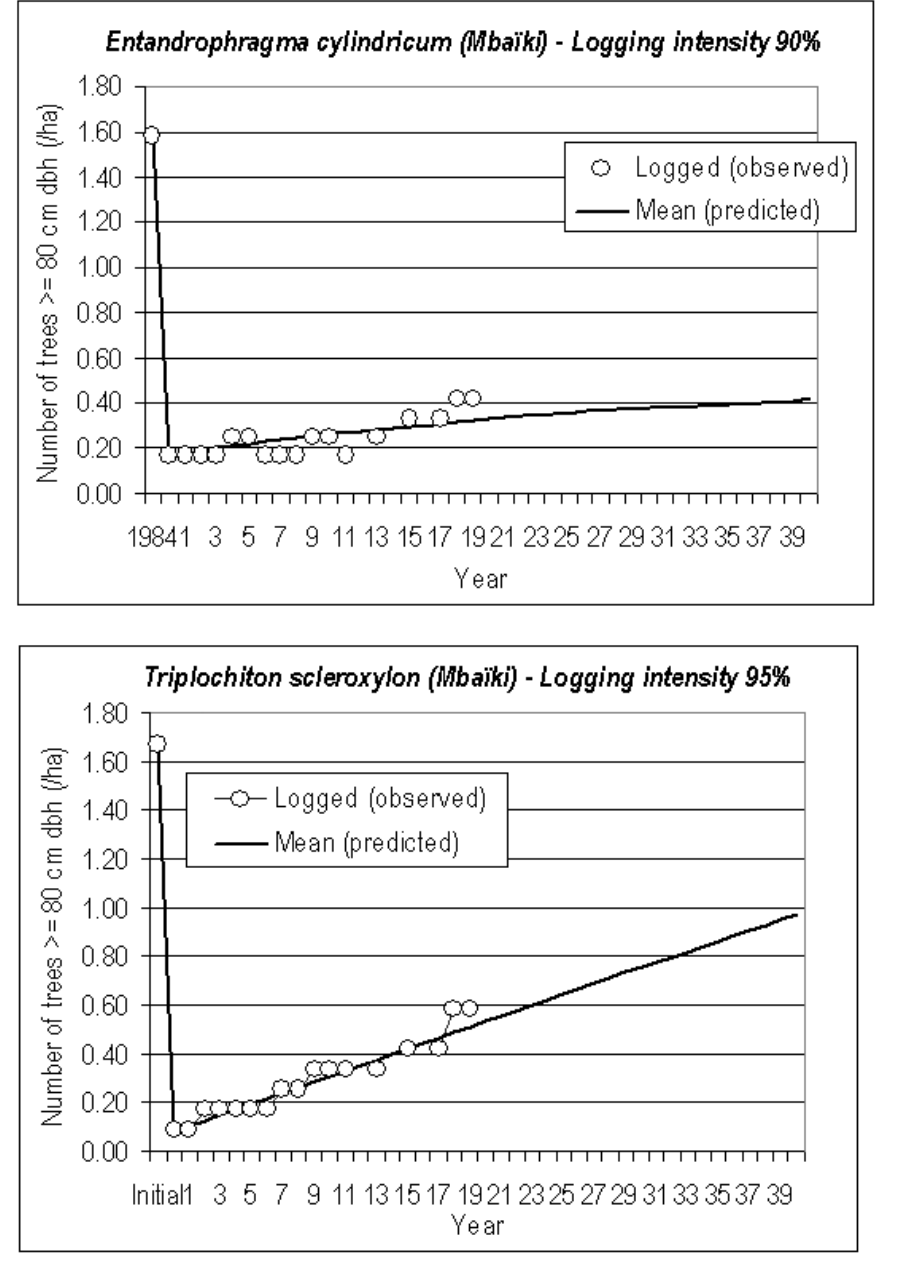
Fig. 1. Evolution of the number of exploitable trees after logging for two important commercial species ( Entandrophragma cylindricum and Triplochiton scleroxylon ) in the Central African Republic (CAR). Predictions were made using a stochastic matrix model calibrated with data from the M'Baïki experimental site in the CAR (methods are described in Gourlet-Fleury et al. 2004, 2005), and were compared to long-term observations from this